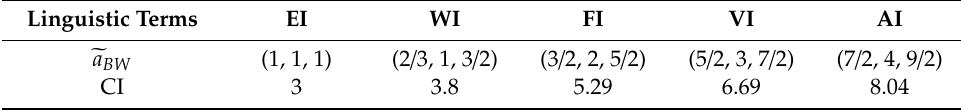
Table 3. Consistency index for fuzzy